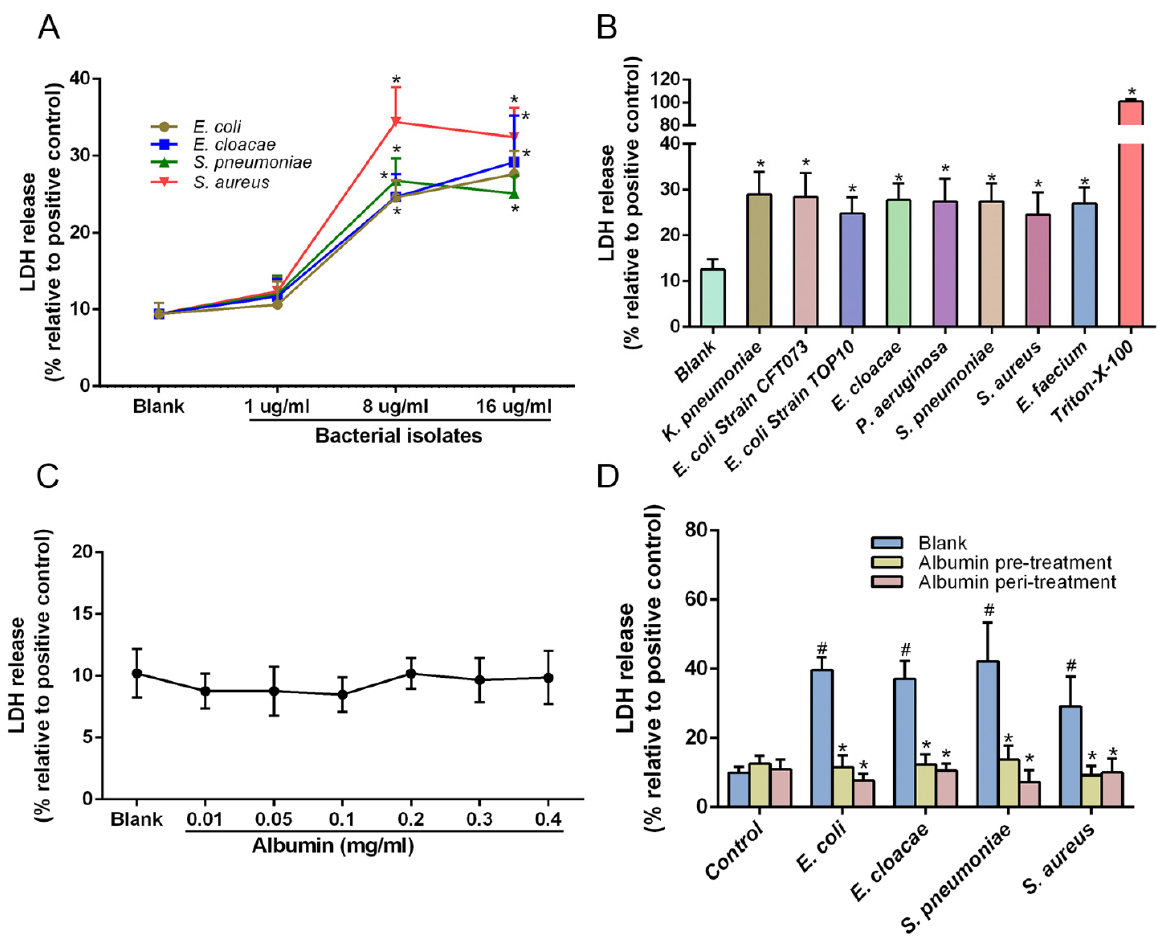
Figure 2. Effects of albumin on the injury induced by bacteria in THP-1. ( A ) The cell damage caused by bacteria products at various concentrations. ( B ) Measurement of the cell damage caused by bacterial components (8 μ g/mL) isolated from indicated bacteria strain from patients with CLDs. ( C ) Toxic measurement of different doses of albumin in THP-1. ( D ) Effects of albumin treatment (0.4 mg/mL) on THP-1 stimulated with bacterial isolates (8 μ g/mL). All LDH data are normalized to a positive control (5% Triton-X-100). The 5% Triton-X-100 was set as a positive control in all LDH measurement assays. Data expressed as means ± SD, * p < 0.05 vs. blank treatment in their own group, # p < 0.05 vs. blank treatment in the control group, n = 6 in each group from three independent experiments.